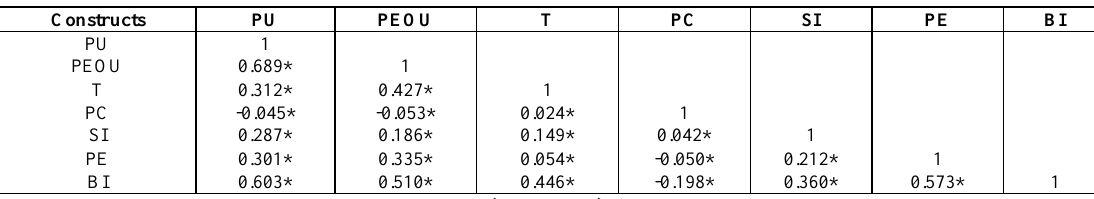
Table 4. Pearson correlation coefficient